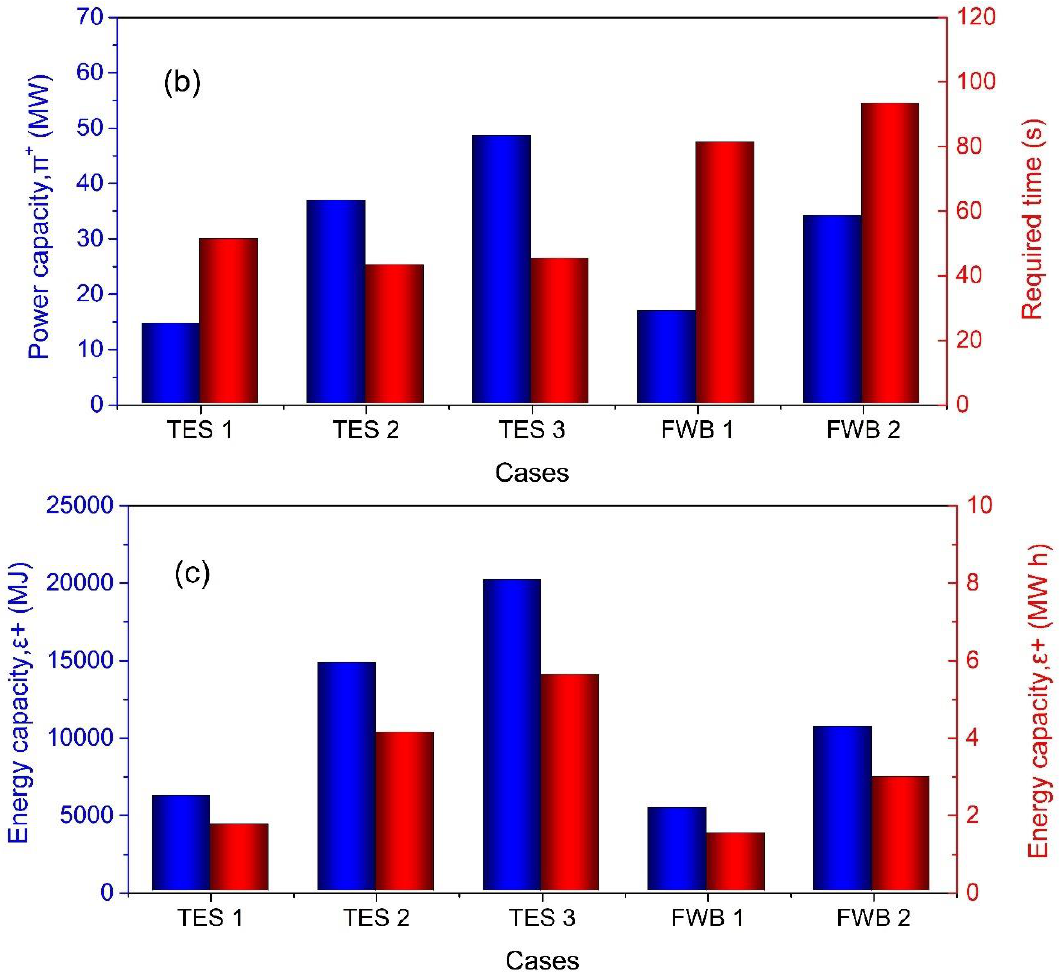
Figure 8. Operational flexibility metrics of a power system under 5 distinct measures (TES1/2/3: throttling extraction steam scenarios 1/2/3, FWB1/2: feedwater bypass scenarios 1/2): ( a ) Average power ramp rate within 1 min; ( b ) Power capacity and required time; ( c ) Energy capacity; Reprint with permission [73]; 2018, Elsevier.